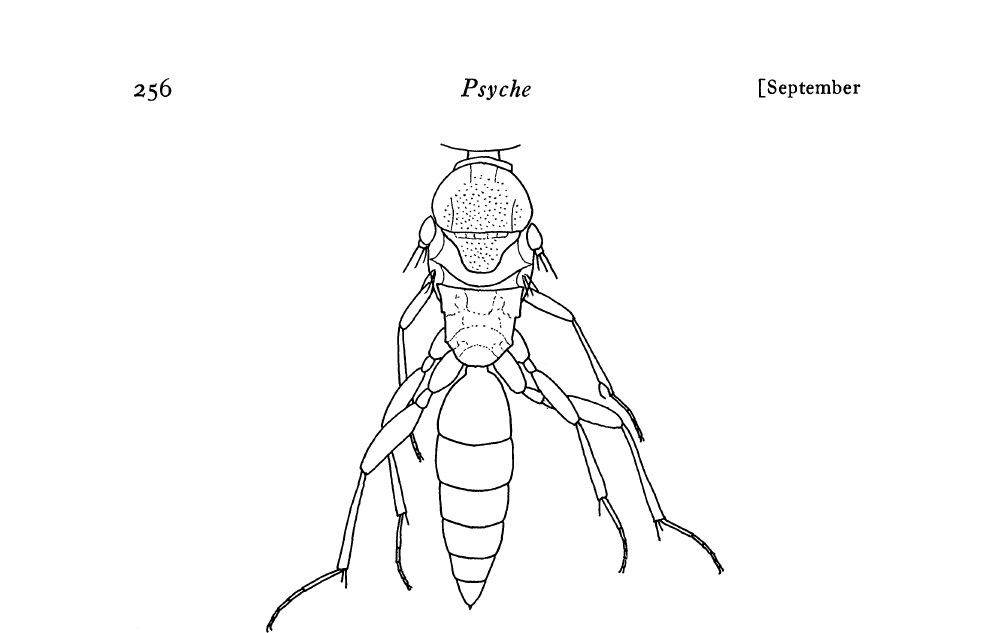
Fig. 3. Lisponema singularis n. sp., dorsal view of type specimen, wings